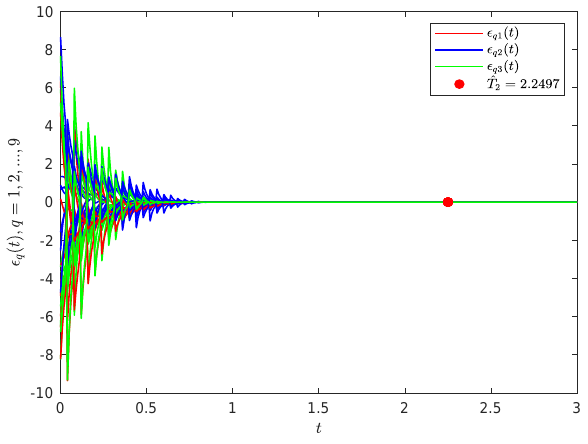
Figure 4. FT synchronization error of network